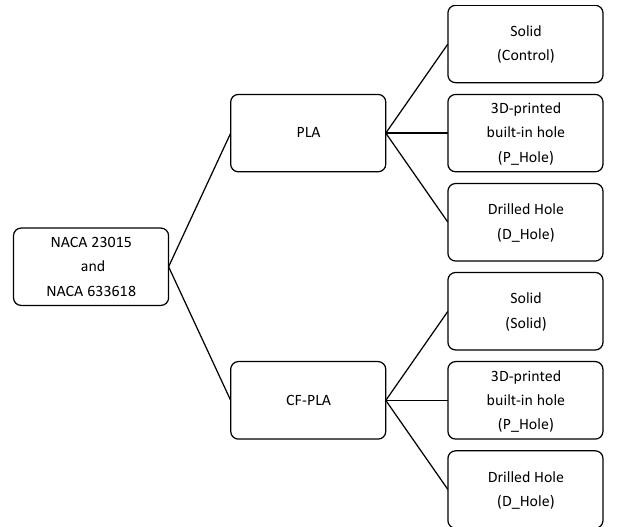
Figure 1. Sample experimentation plan.